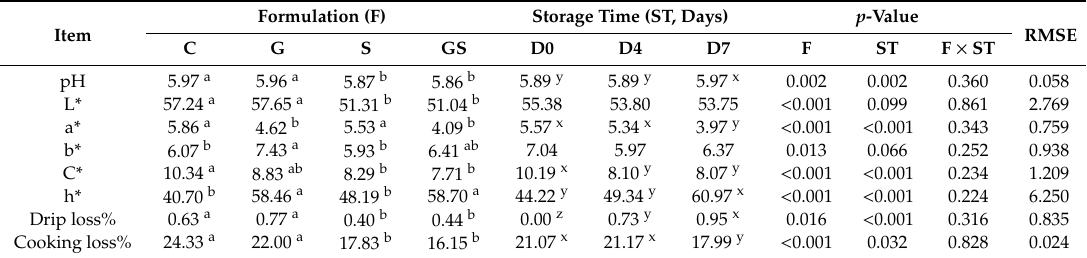
Table 1. pH, colour parameters and water holding capacity of raw rabbit burgers. Formulation Item